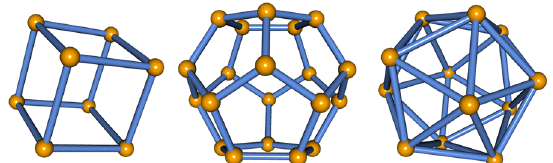
Figure 9. The cube ( left ), the dodecahedron ( center ) and the icosahedron ( right ) all have χ =